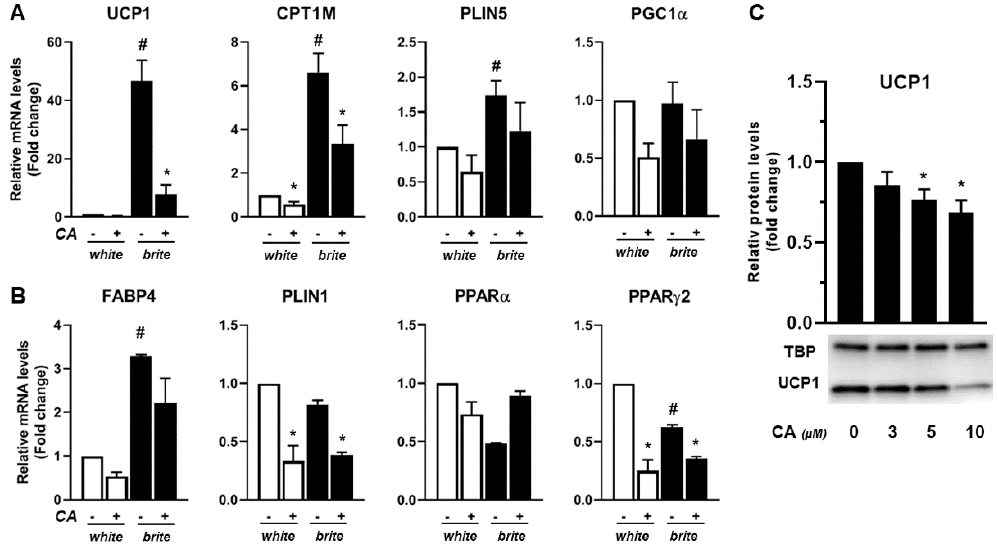
Figure 2. CA inhibits thermogenic marker gene expression of human brite adipocytes. White or brite hMADS adipocytes (at day 18) were maintained in the absence ( − ) or the presence ( + ) of 10 µ M CA between days 18 to 22, and mRNA levels of thermogenic ( A ) and adipogenic ( B ) markers were analyzed. Forty micrograms of total protein extracts were analyzed by Western blot ( C ) representative of three experiments. Histograms display mean ± SEM of three independent experiments; paired student, p < 0.05 was considered significant: #, white vs. brite adipocyte; * , untreated vs. CA treated condition.